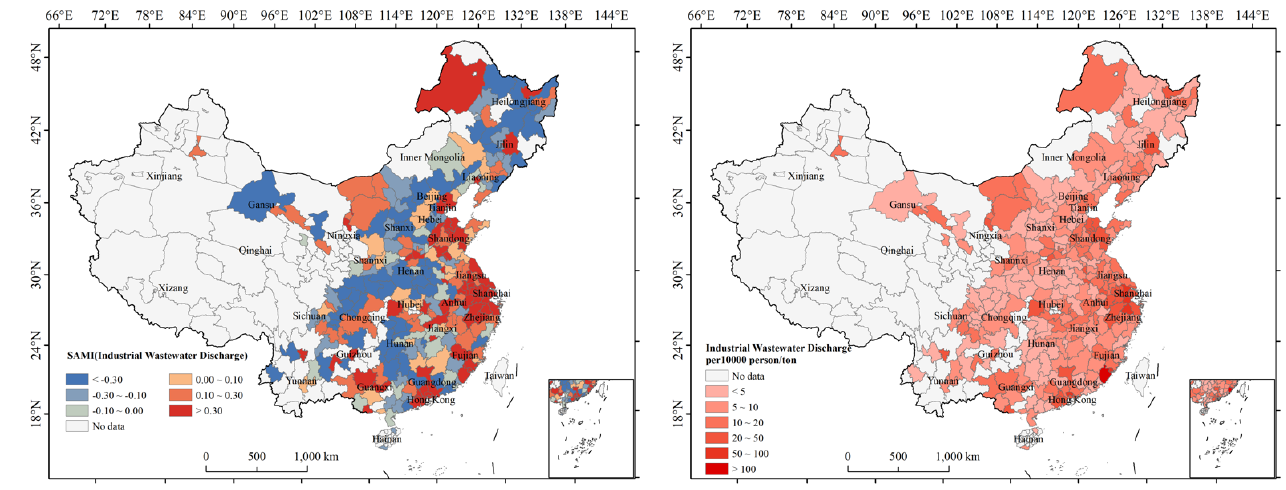
Figure 3. Spatial distribution of SAMI and per capita value of selected resilience indicators in 267 prefectural cities in China in 2019.